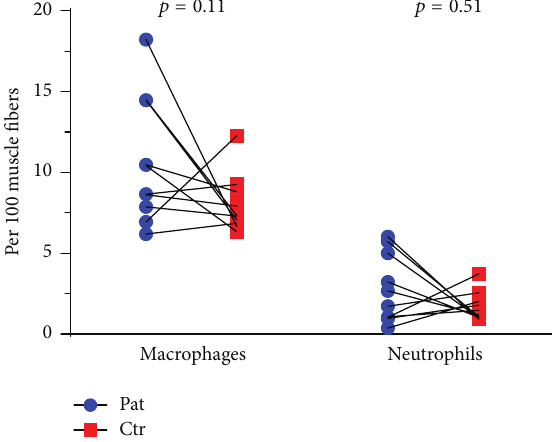
Figure 3: Myonuclear domain for muscle fiber type I and type II in m.vastuslateralis .Linesdrawnsignifythepairwisematchofpatient- control.